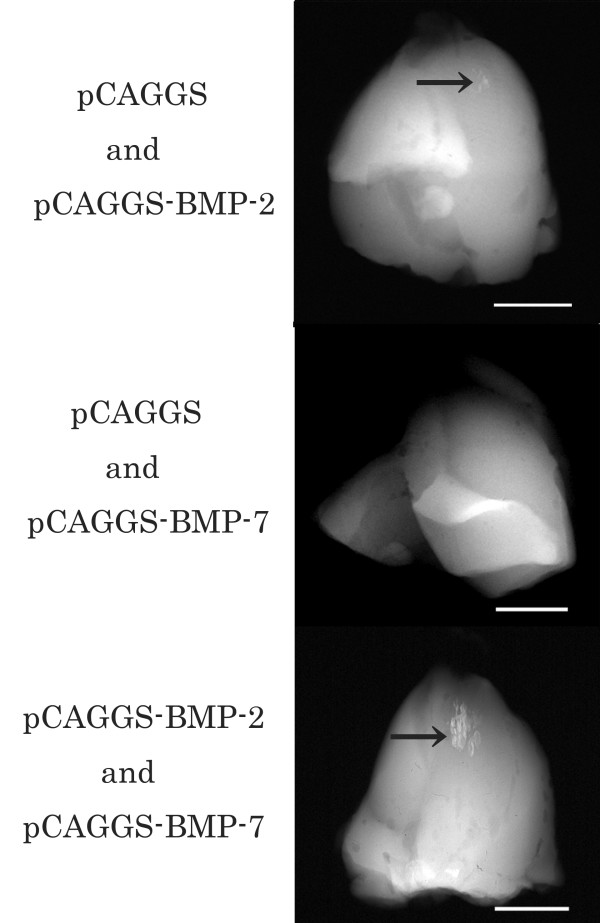
Soft X – ray analysis 10 days after in vivo electroporation. Soft X-ray images of target muscles on day 10 after gene transfer with pCAGGS and pCAGGS-BMP-2, pCAGGS and pCAGGS-BMP-7, or pCAGGS-BMP-2 and pCAGGS-BMP-7. Radio-opaque areas were seen after electroporation with pCAGGS and pCAGGS-BMP-2 (arrow) or pCAGGS-BMP-2 and pCAGGS-BMP-7 (arrow). No opacities with well-defined margins were detected in muscles that received pCAGGS and pCAGGS-BMP-7 by electroporation. Scale bar: 10 mm.